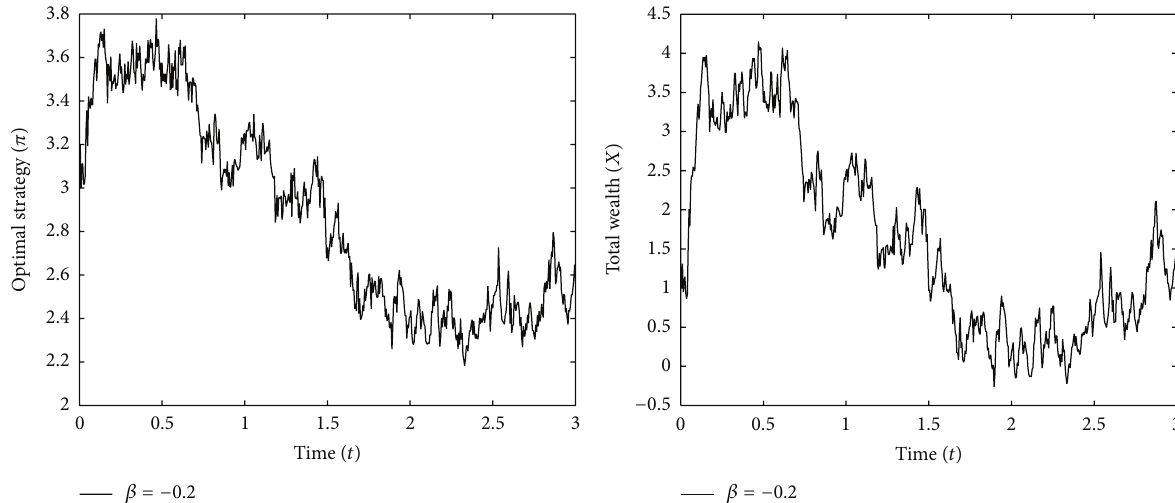
Figure 12: The evolutions of optimal strategy and total wealth over time ( 𝛽 = −0.2